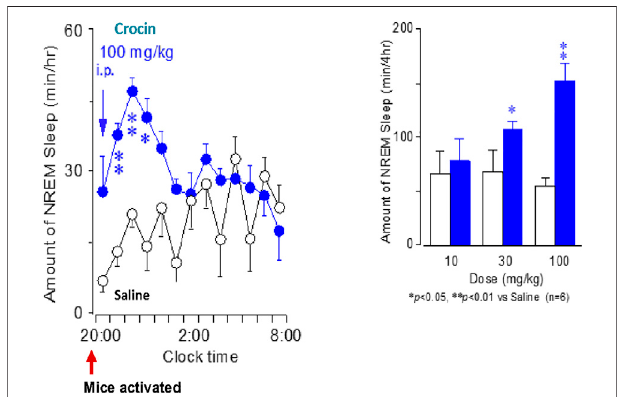
FIGURE 3 | The effect of crocin on sleep architecture in a mouse